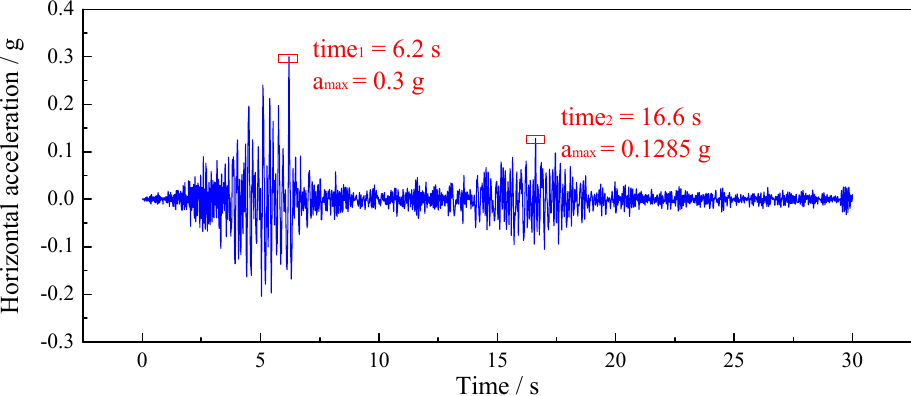
Figure 9. Acceleration time history curve of the Wolong station seismic record of Wenchuan earthquake.